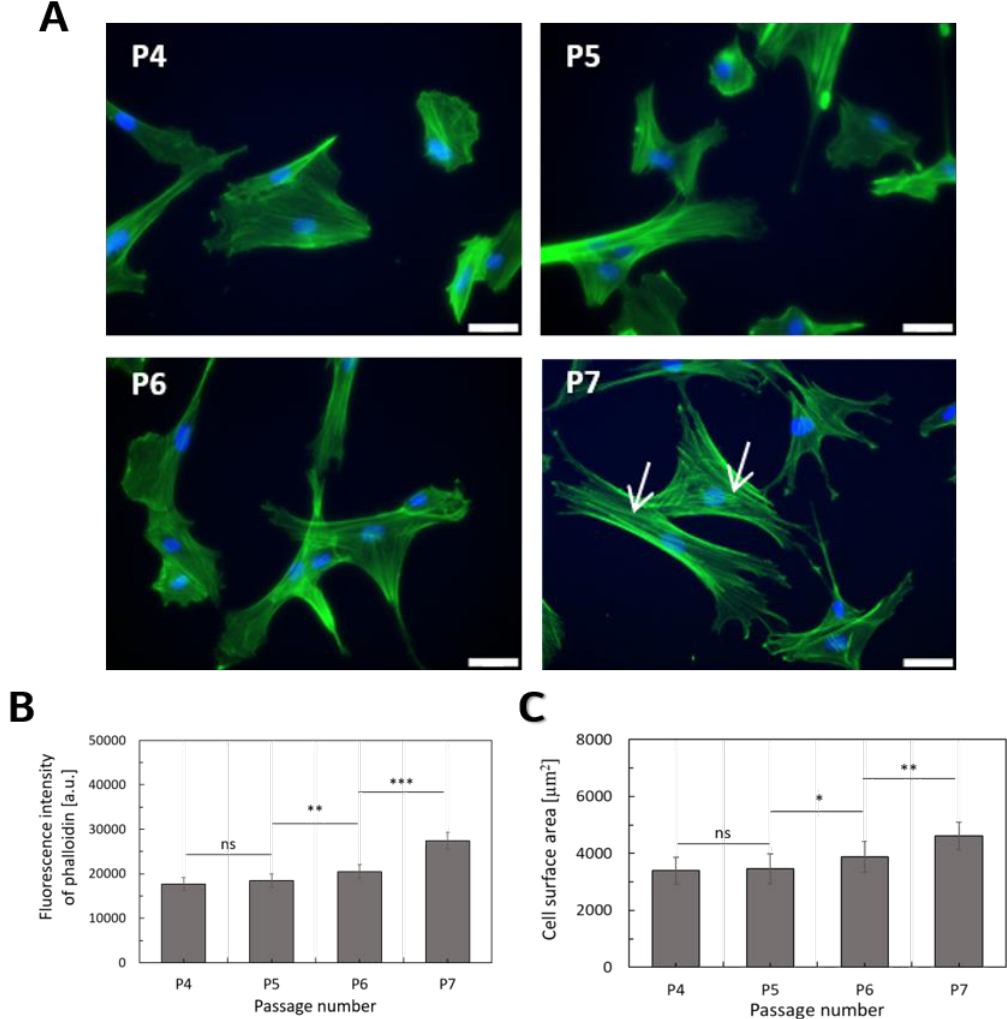
Figure 5. ( A ): Representative fluorescence microscopy images of WJ-MSCs at four di ff erent stage of in vitro cultivation (P4, P5, P6, P7). Some morphological changes were observed during long-term culture. Actin filament (green) distributions at four di ff erent stages of in vitro cultivation (P4, P5, P6, P7). The white arrows indicate thick, polymerized F-actin fibers. Phalloidin labeled with Alexa-Fluor 488 was used as a dye. Scalebar = 50 µ m. ( B ): The change in phalloidin binding from P4 to P7 determined as a mean ± standard deviation and the average of 3 donors. Student’s t test was applied to statistically verify the obtained results (ns: no significant di ff erence). ( C ): Cell surface area changes from P4 to P7 determined as a mean ± standard deviation for ~1000 cells, an average of 10 donors. The area occupied by single cells was determined by analyzing the cellular shape based on the fluorescence images of actin filaments. Student’s t-test was applied to statistically verify the obtained results (ns: no significant difference).